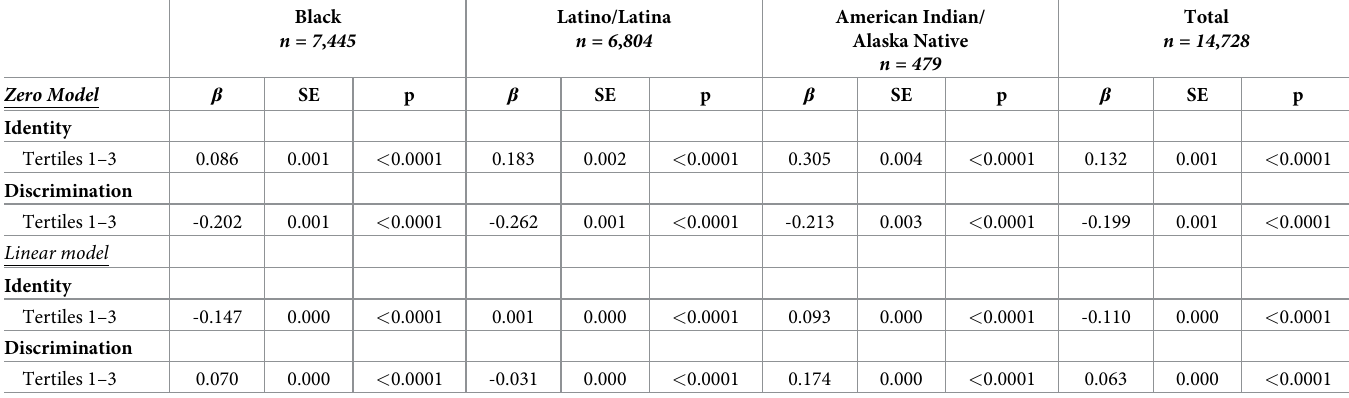
Table 2. Model results for zero-inflated Poisson regression (NESARC-III,